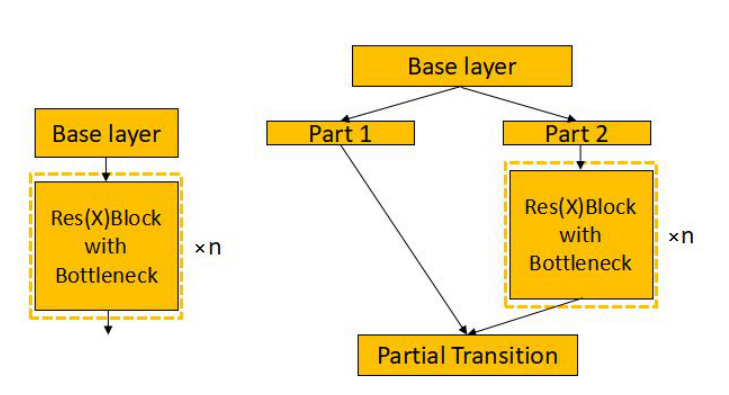
Figure 2. CSPDarknet53 structure. The figure on the left shows the structure of Darknet53, while the figure on the right shows the CSPDarknet53 structure with improvements made to the Dark- net53 structure.